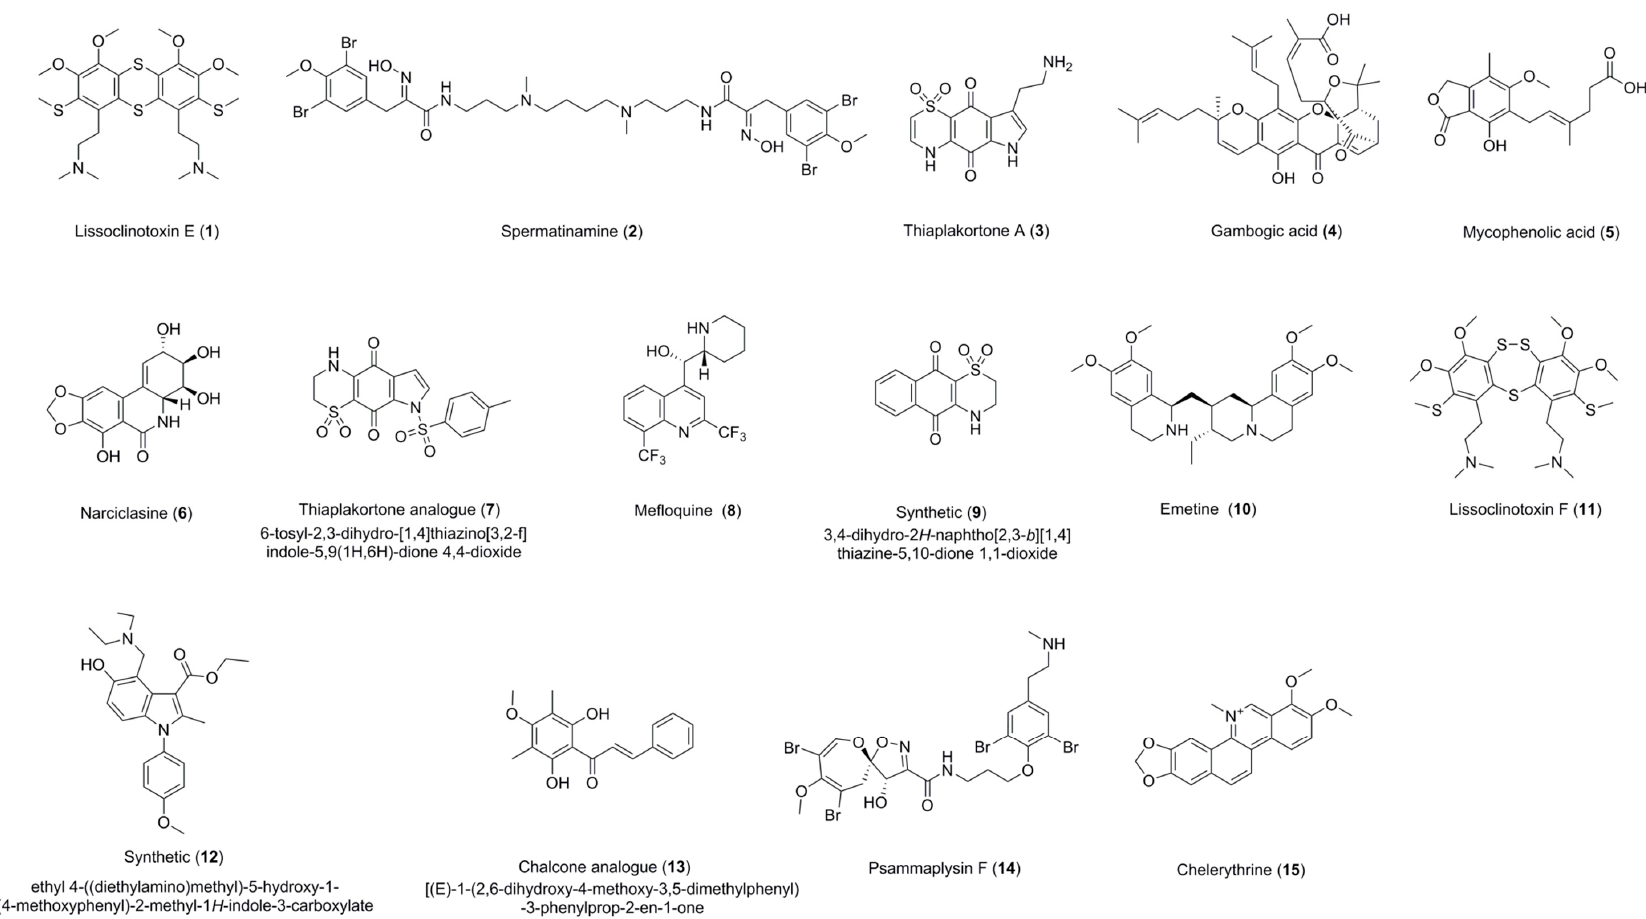
Figure 1. Structures of compounds 1 – 15 .